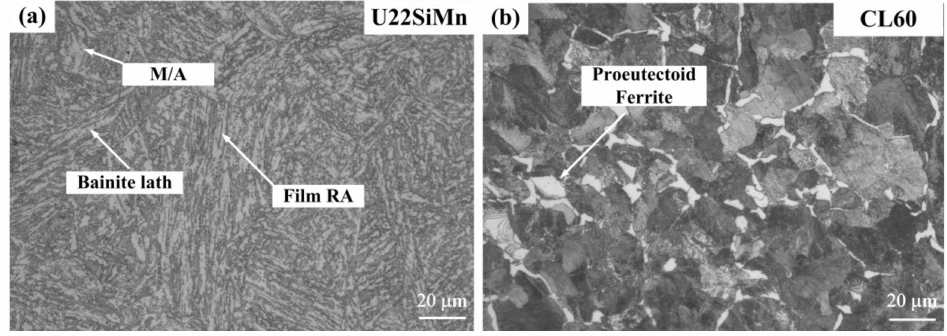
Figure 2. OM observation of the microstructures of bainitic steel; and ( a ) pearlitic steel ( b